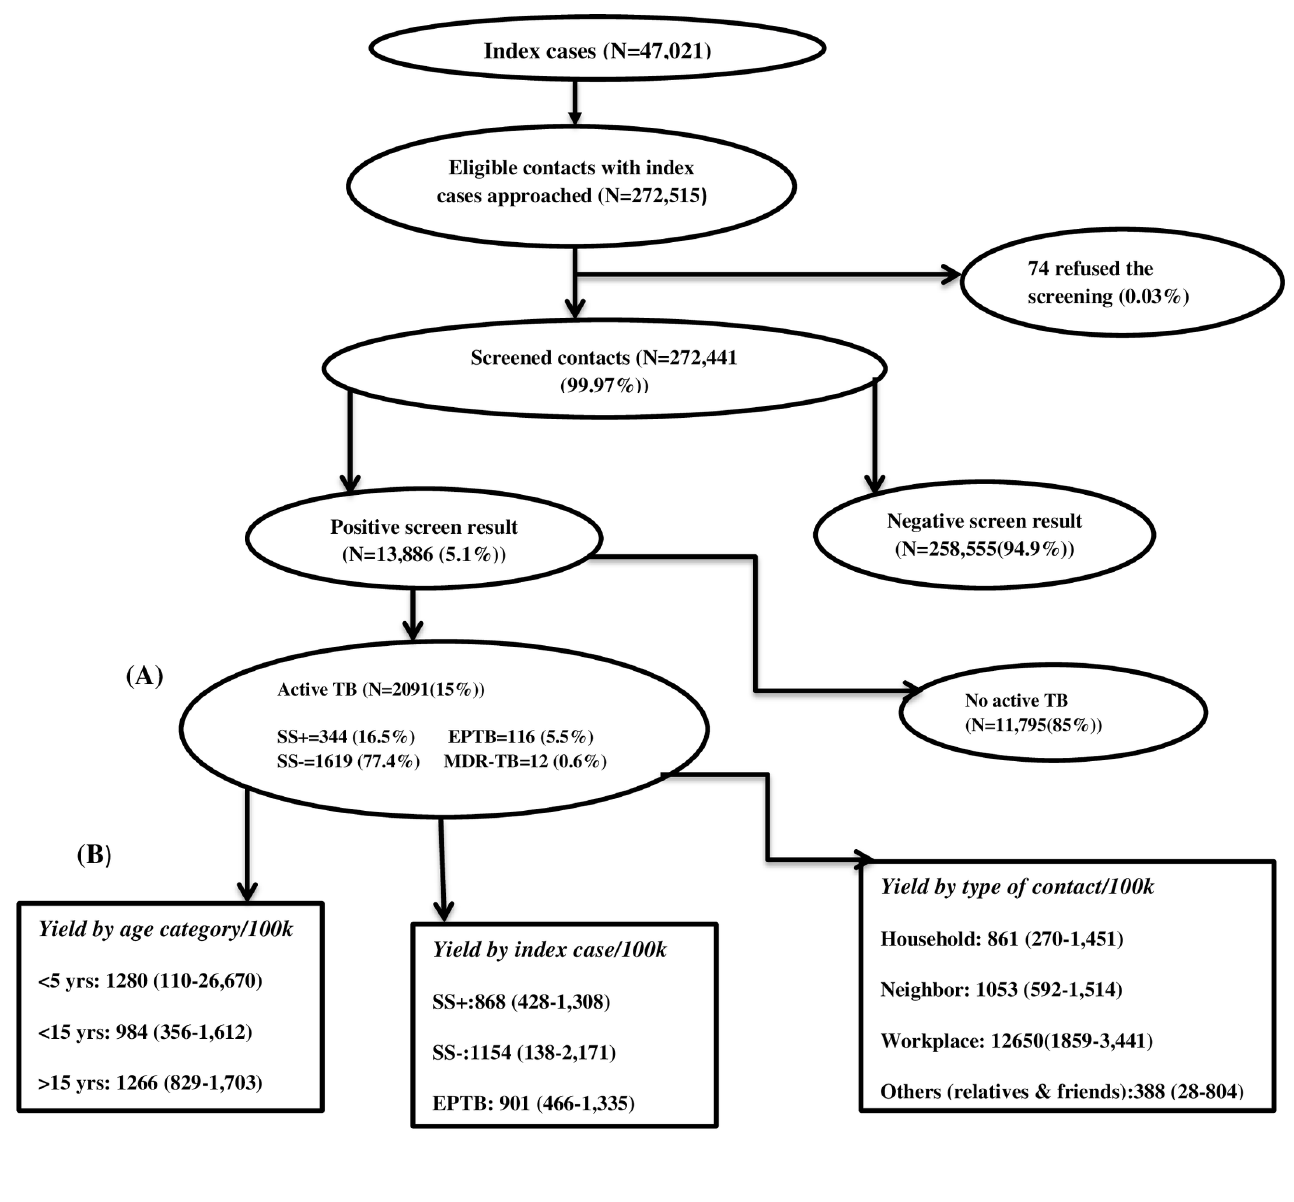
Fig 1. Flow diagram of screening and yield of retrospective contact investigation, June-October 2014, Ethiopia.